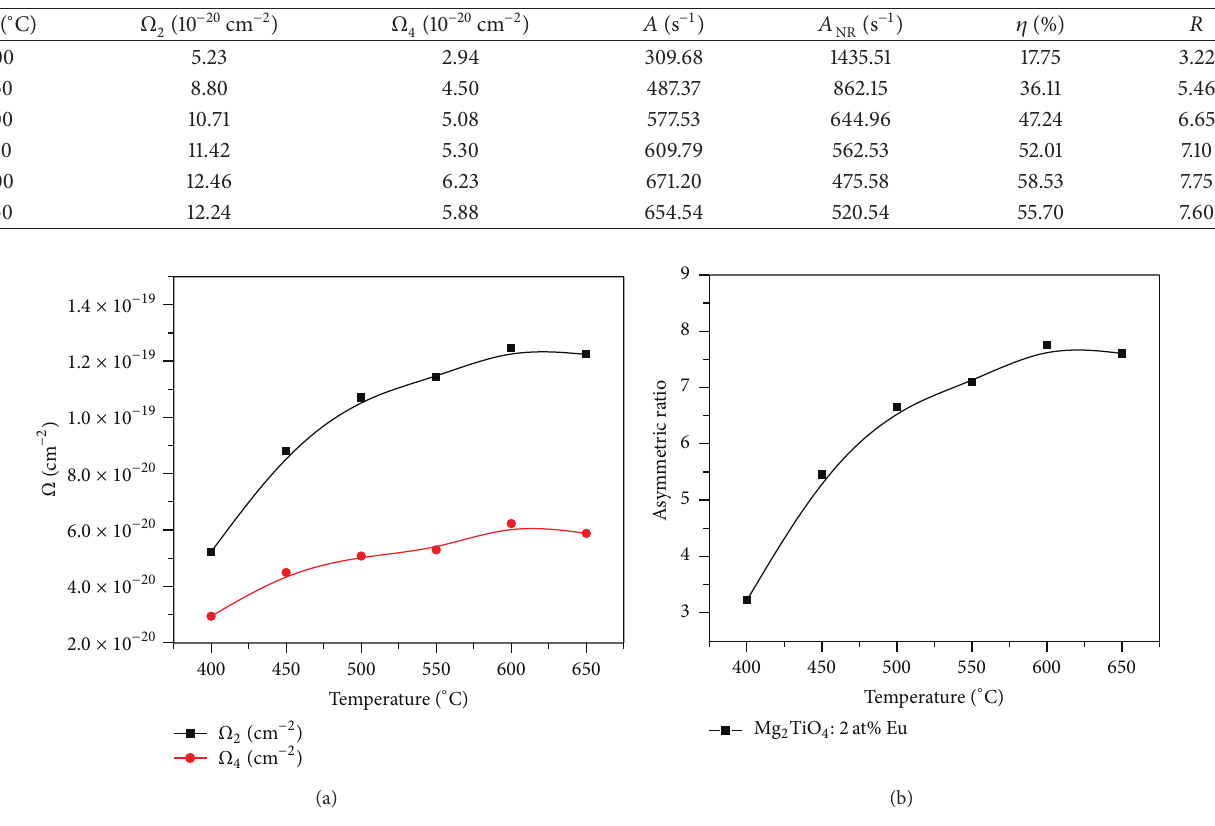
Figure4:(a) Ω 2 (blacksquares)and Ω 4 (redcircles)intensityparametersand(b)asymmetricratioofEu 3+ emissioninMg 2 TiO 4 nanoparticles prepared at different